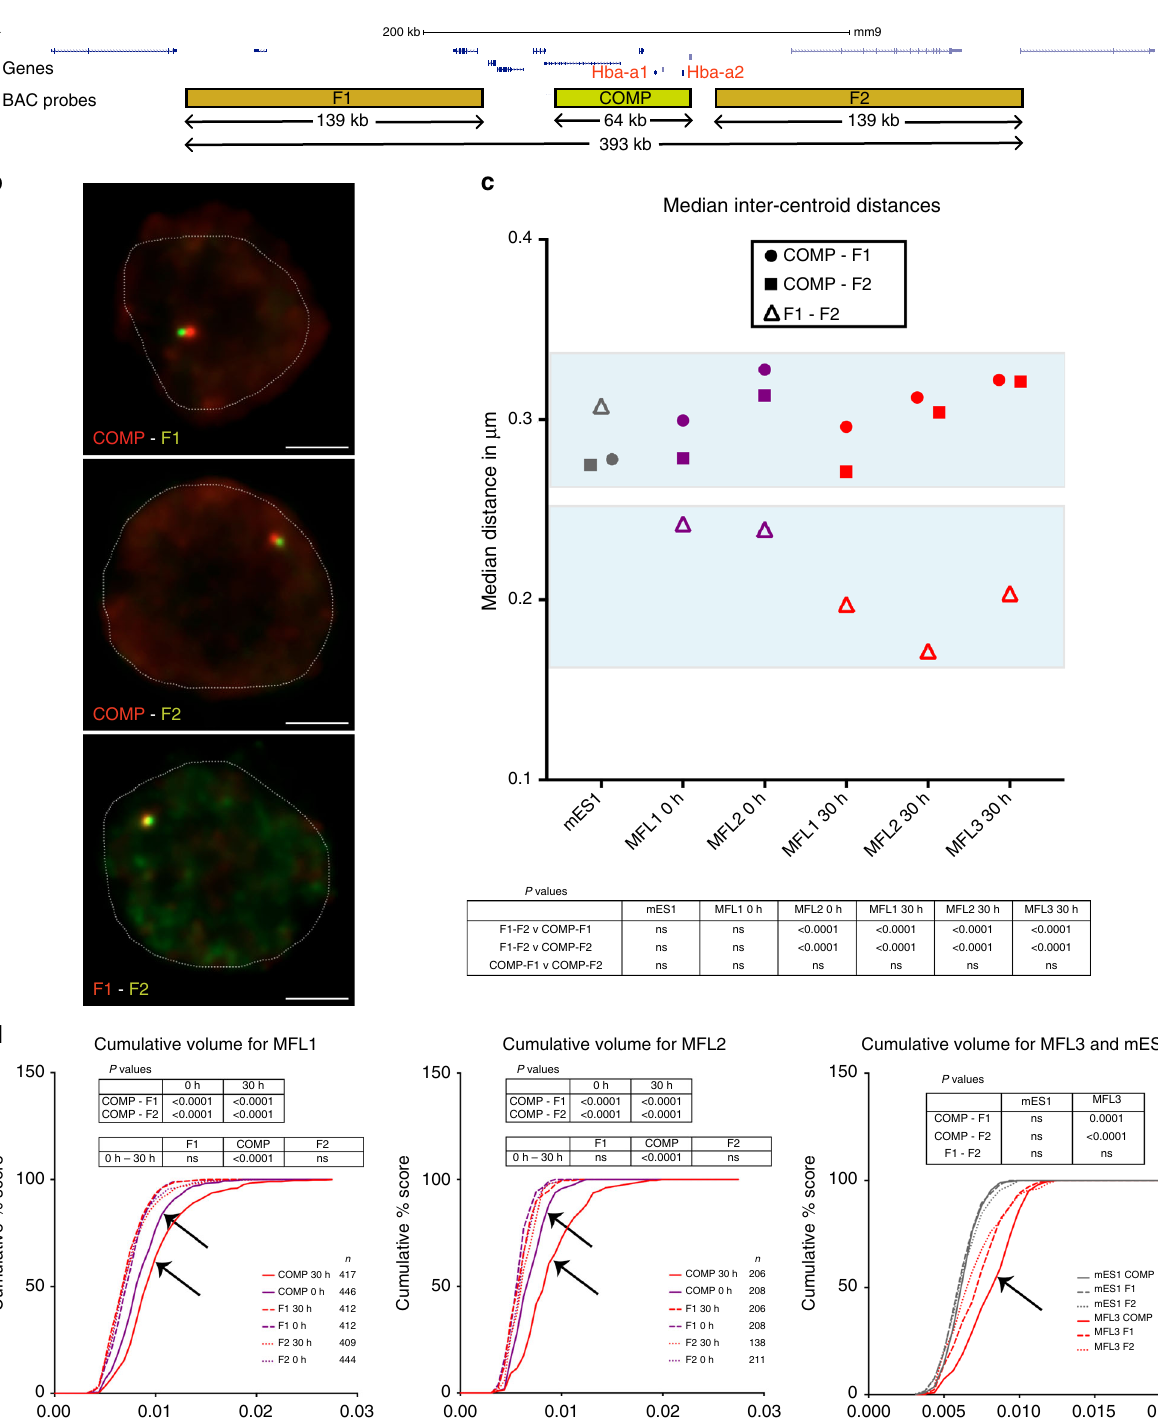
Fig. 3 Volume and proximity measurements across the α -globin locus in WT mice. a Gene map and locations of the BAC FISH probes to scale, with genomic distances encompassed. b Representative images for the three BAC probe pairs in MFL 30 h erythroblasts with nuclei delineated (white dotted line). Scale bar 2 μ m. c Median inter-centroid distances between the three probe pairs indicated, in mES cells (grey) and erythroblasts at 0 h (purple) and 30 h (red) timepoints. MFL1, 2 and 3 represent cultures from three individual foetal livers. Light blue shading emphasises proximity of the fl anking regions F1 – F2 in erythroblasts. n = 87 – 236 — see Supplementary Fig. 3 for the complete data set. d Cumulative frequency plots of BAC signal volumes in mES cells (grey) and erythroblasts at 0 h (purple) and 30 h (red). COMP values indicating expanded volume are arrowed. All P values are derived by a Kruskal – Wallis test with Dunn ’ s multiple comparisons. ns not signi fi